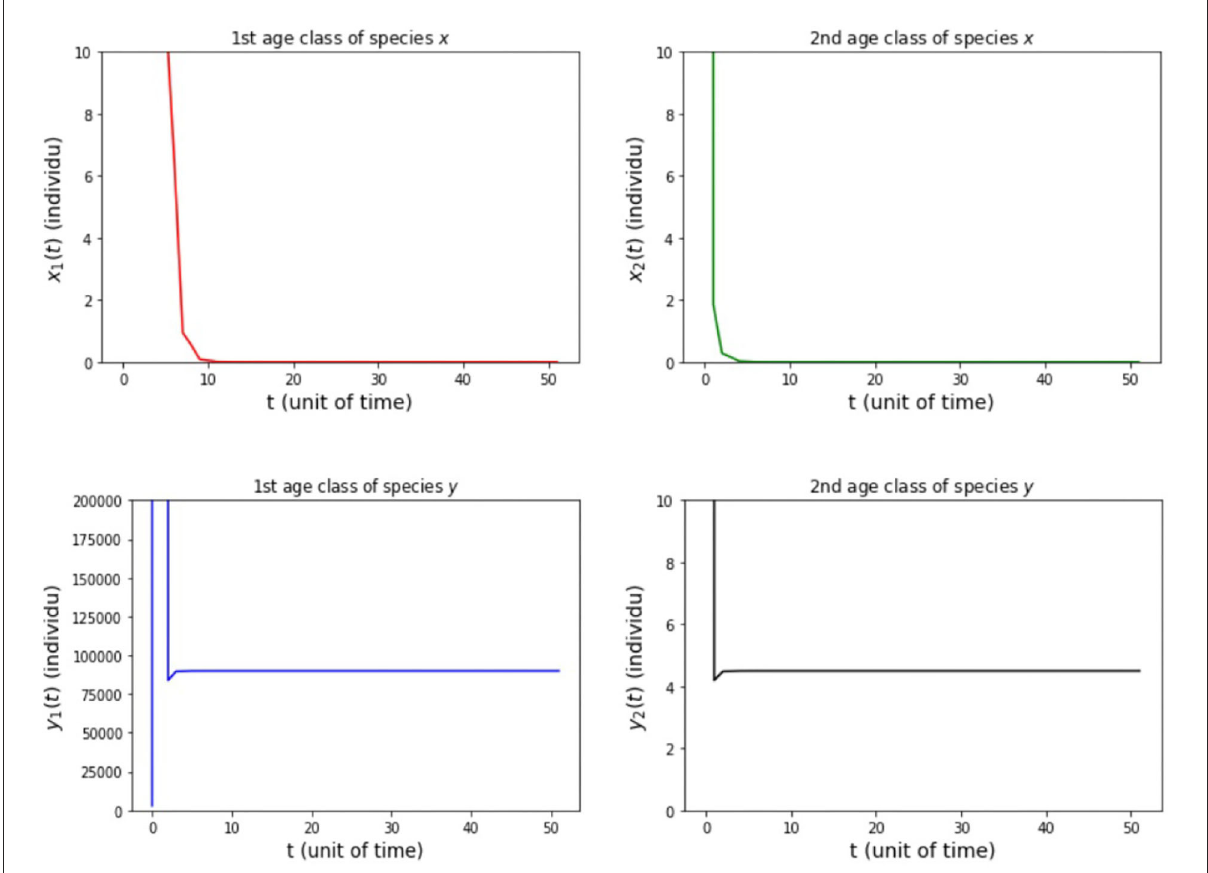
FIGURE7 Population growth of each age class from case (iii) Model